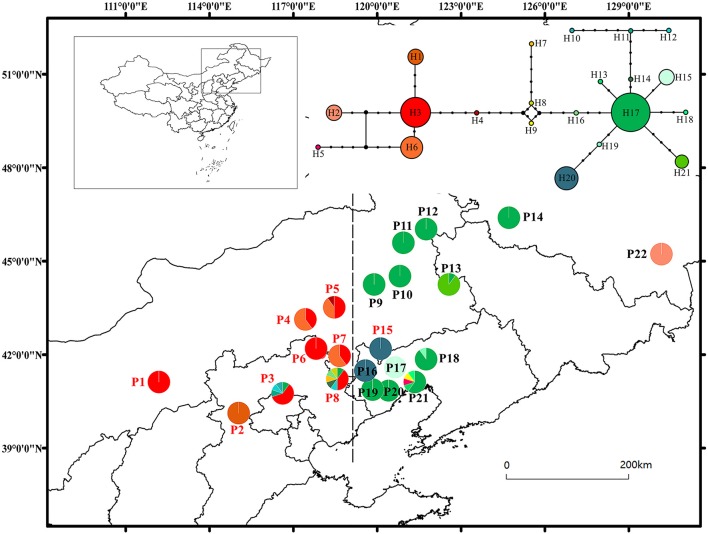
Map showing the locations of sampled populations, median-joining haplotype network and geographic distributions of the 21 chlorotypes found in the Siberian apricot. Population labels with different colors correspond to two genetic clusters identified by the program STRUCTURE: red, northern group; black, northeastern group. The dotted line is the boundary between the eastern and western groups. Circle sizes are proportional to the number of samples per chlorotype.